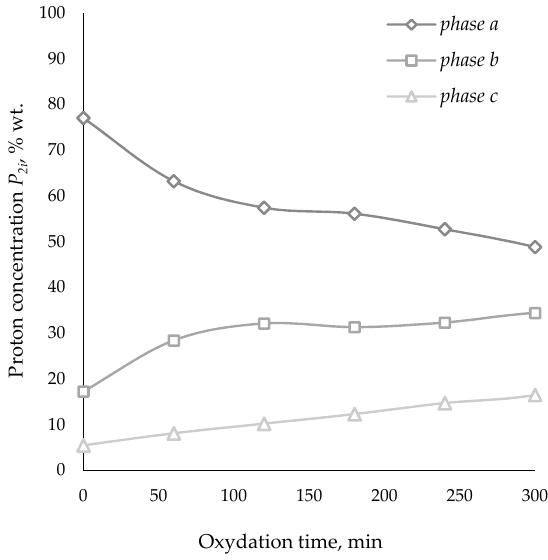
Figure 5. Proton concentration P 2 i of catalytic oxidized products of HRO vs. time. An increase in the viscosity of oxidation products of HRO with an increase in the duration of the process is due to an increase in the content of resins and asphaltenes in them and to a high degree of their association with the formation of a rather strong structure, as evidenced by a decrease in the spin–spin relaxation time of phases. Pulsed NMR parameters (spin–spin relaxation time T 2 i and proton concentration P 2 i ) reflect thermodynamic properties of components of the HRO oxidation products, and depend on their dynamic viscosity. The viscosity of the HRO oxidation products is defined by the composition and mobility of components: HC, resins and asphaltenes. An inverse dependence of the viscosity and molecular mobility of components of HRO oxidation products is observed (Figure 6).